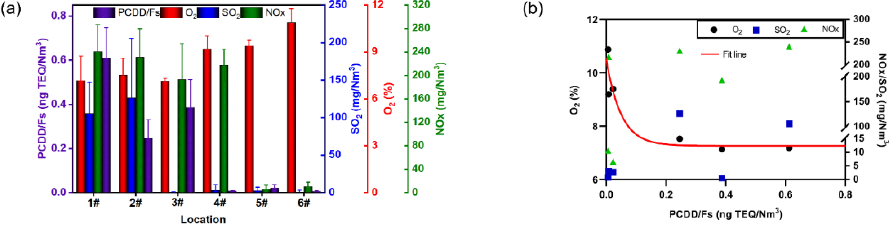
Figure 2. Characteristics of ∑ PCDD/Fs and flue gas components, based on the three tested values: ( a ) emissions of ∑ PCDD/Fs and flue gas components; ( b ) correlations of ∑ PCDD/Fs and flue gas components.